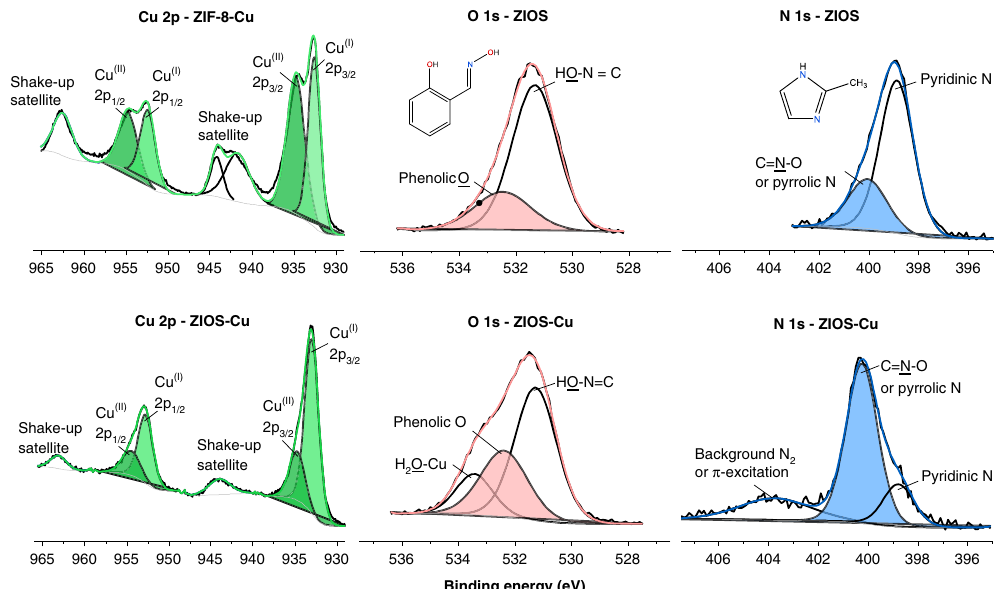
Fig. 4 X-ray photoelectron spectroscopy results. XPS spectra for ZIOS before and after copper adsorption (Cu 2 p , O 1 s , and N 1 s binding energy curves) and for ZIF-8 after copper adsorption (Cu 2 p binding